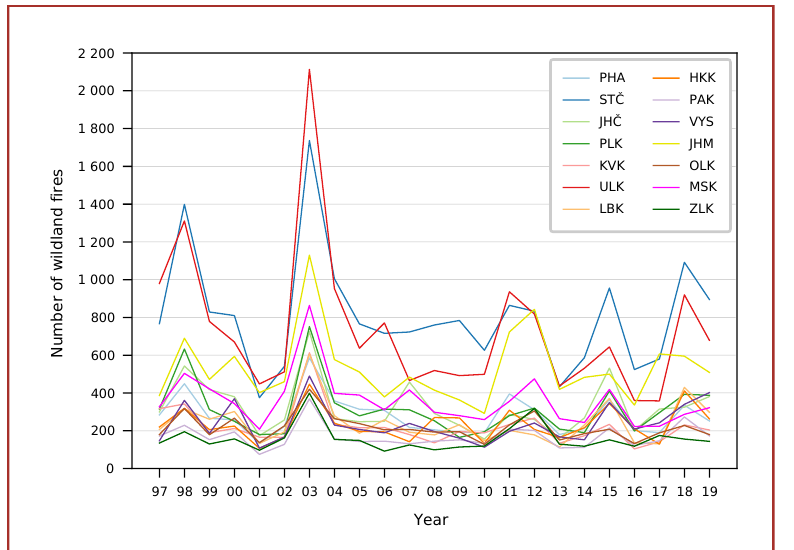
Figure 3. Time-series of number of wildland fires in 14 regions of the Czech Republic, including the Capital City of Prague. The order of the regions respects the order in the Constitutional Act of the Czech Republic [11] which establishes these regions [12]. The same ordering is used in the following